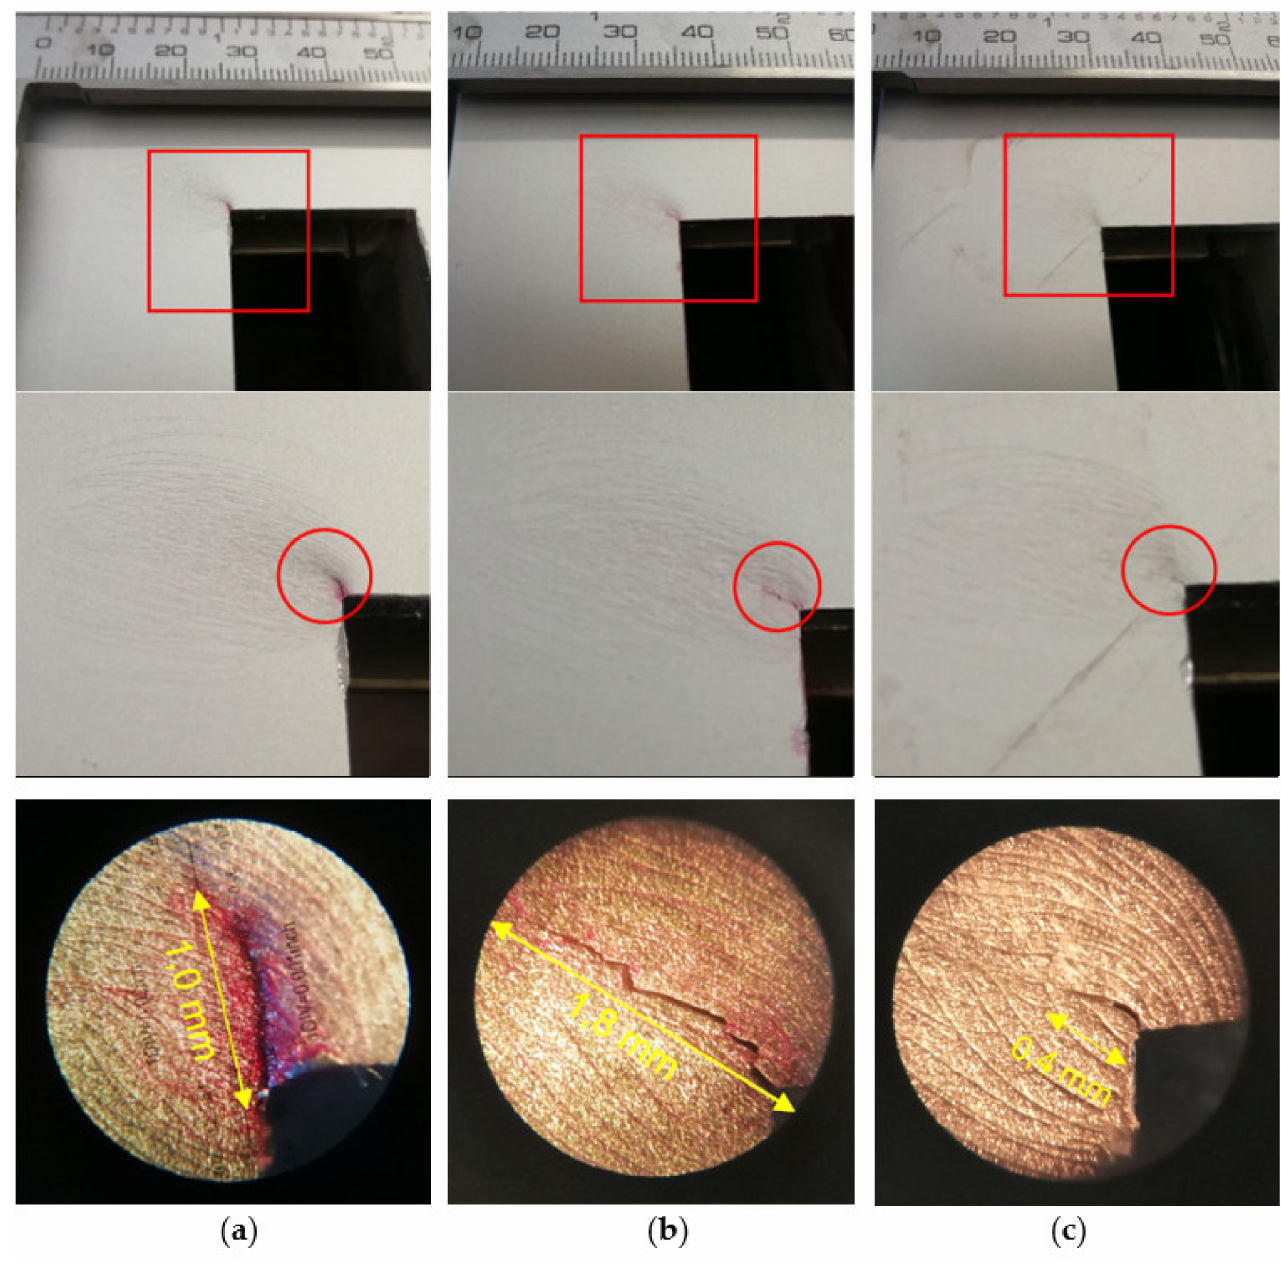
Figure 12. Cracks in specimens with the sharp root: ( a ) C_N1_1, ( b ) C_N1_2, ( c ) C_N1_3. This microcracking of the surface finish was also visible on specimens with rounded roots and with semi-circular roots. However, on these specimens, no cracks in the alu- minium alloy wall occurred. The aluminium material around the root of the notch did under-go a yield, observable from the residual deformation, which is approximately 1 mm at the opening of the notch, but without initiating cracks (Figure